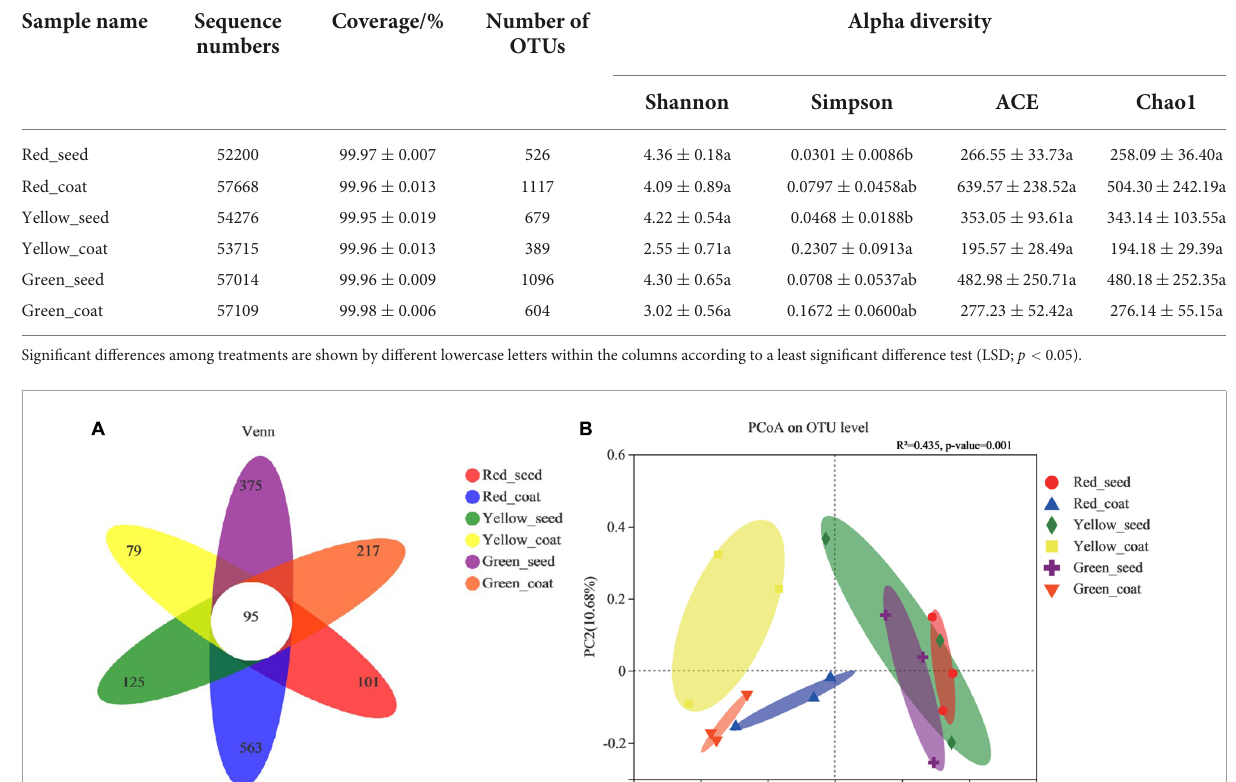
TABLE 1 Alpha diversity indices in each treatment ( ± SEM, n = 3/treatment).